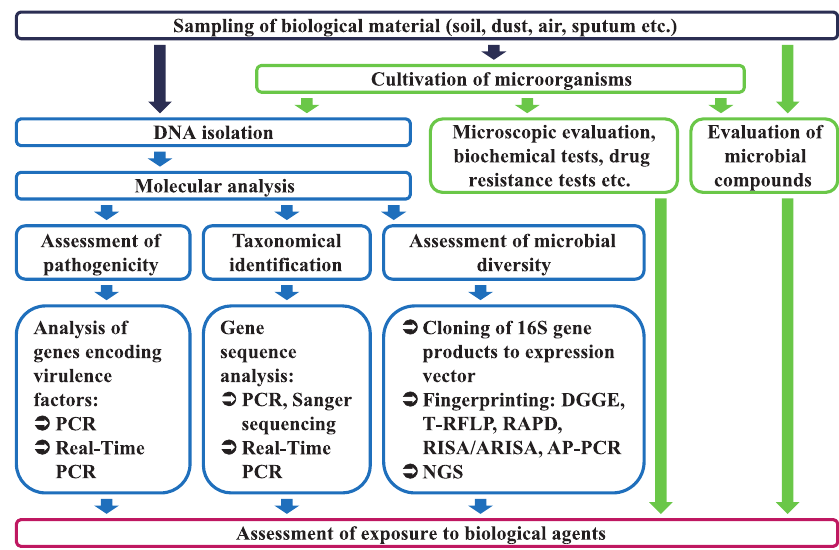
Fig. 2 Procedure in the assessment of exposure to harmful biological